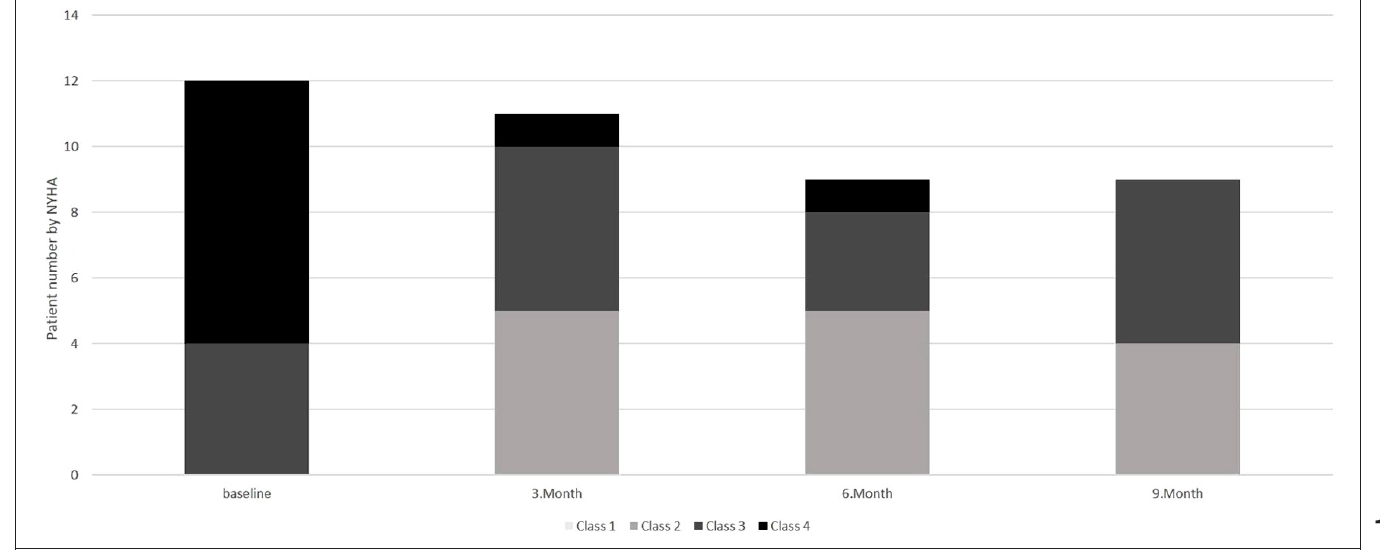
Figure 5. Temporal change of functional capacity by NYHA class ( P < .0001). NYHA, New York Heart Association.